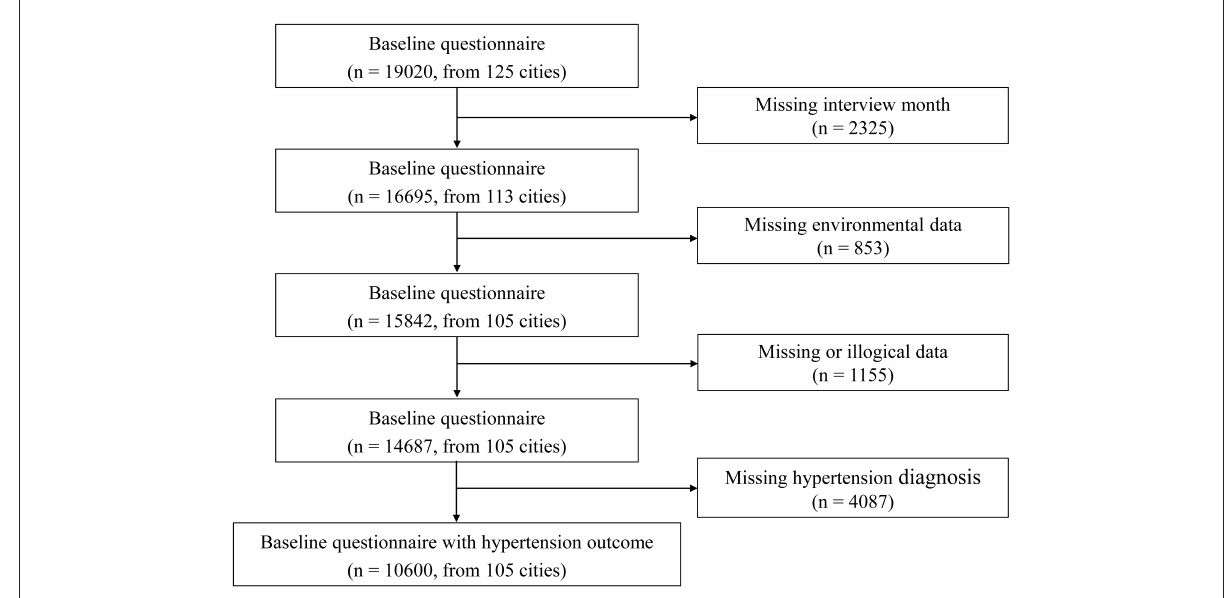
FIGURE1 Flow chart of selection